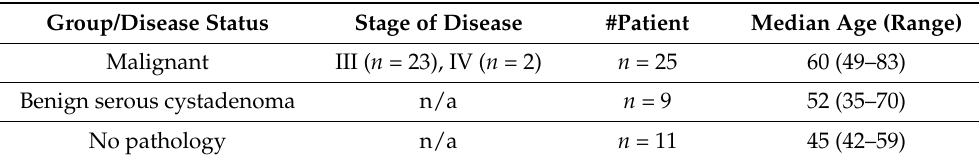
Table 2. Summary of Cohort